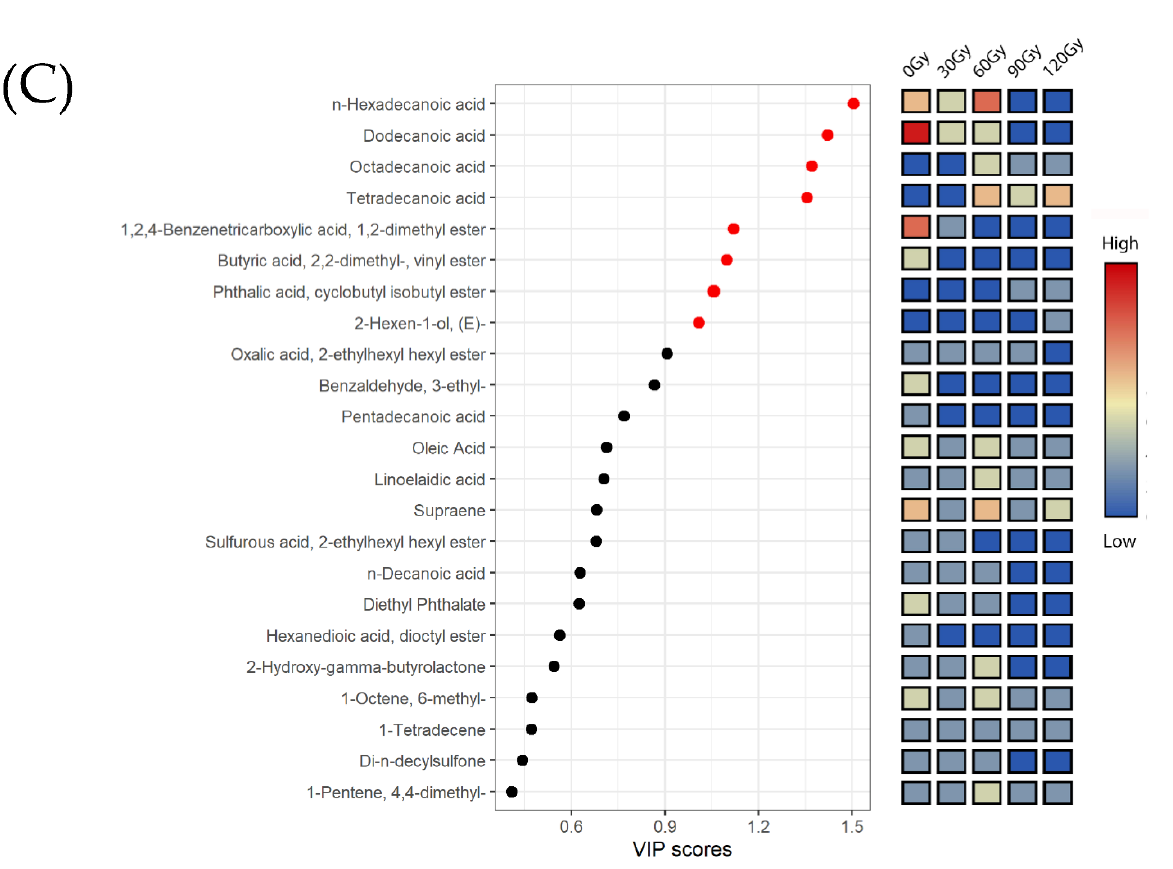
Figure 3. Principal component analysis (PCA) score plot ( A ), partial least squares-discriminant analysis (PLS-DA) loading plot ( B ), and variable importance projection (VIP) scores plot ( C ) of all metabolites in B. dorsalis larvae exposed to different doses of irradiation treatment at 0 Gy, 30 Gy, 60 Gy, 90 Gy and 120 Gy.